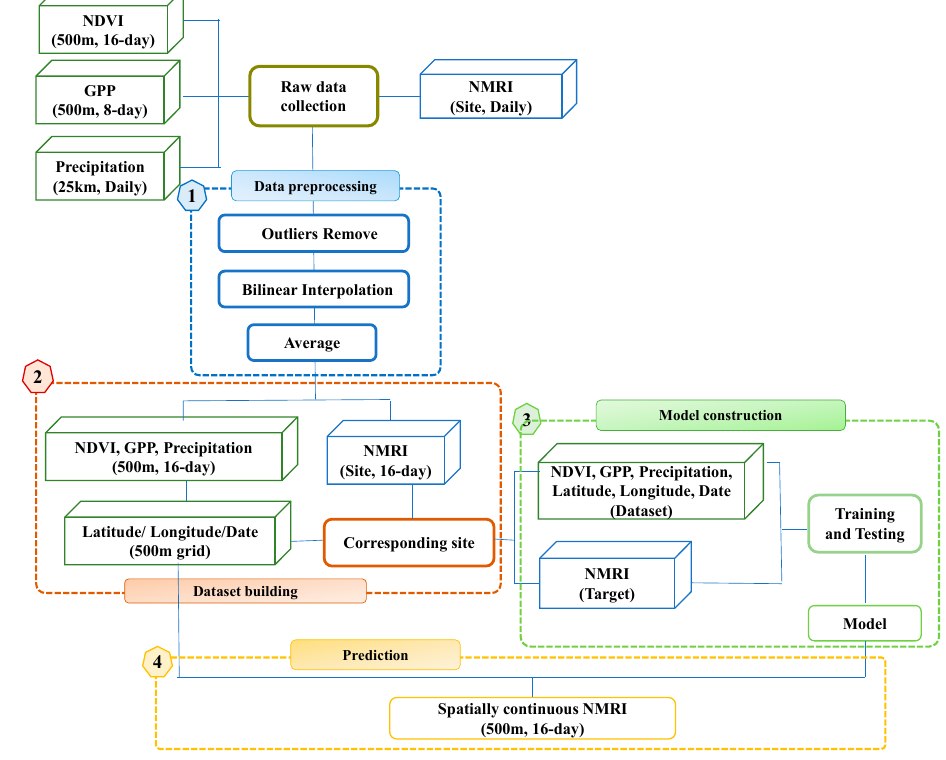
Figure 2. Flowchart of the point–surface fusion model used in this study .